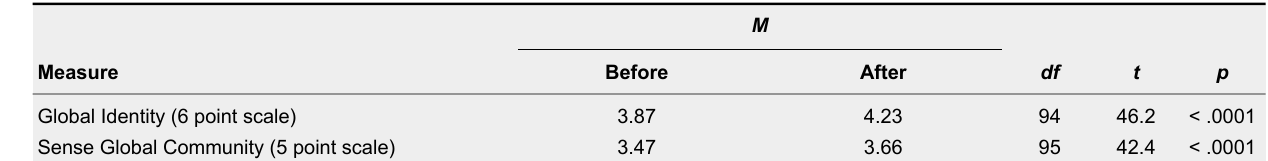
Scores Before and After Presentations on Global Community Measure